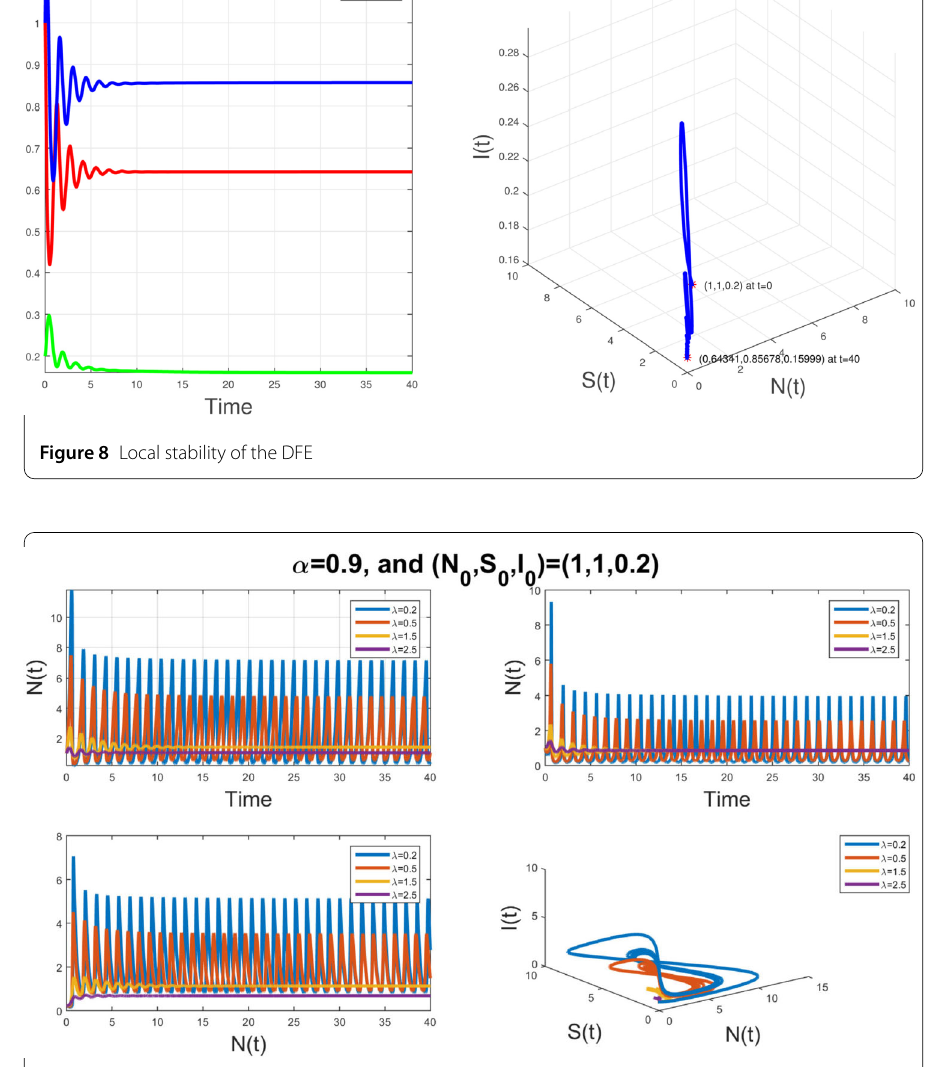
Figure 9 Influence of the solitary hunting on the coexistence of the population